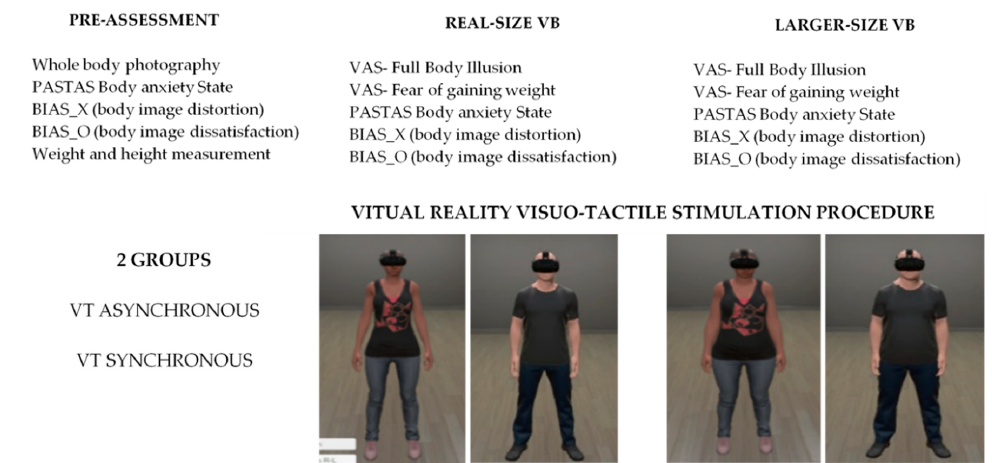
Figure 1. Experimental design scheme. Between-subjects group condition (synchronous versus asynchronous), within-subjects assessment condition (pre-assessment, real-size and larger-size virtual bodies), and dependent variables reported. VT = visuo-tactile, VB = virtual body, VAS = visual analog scales.